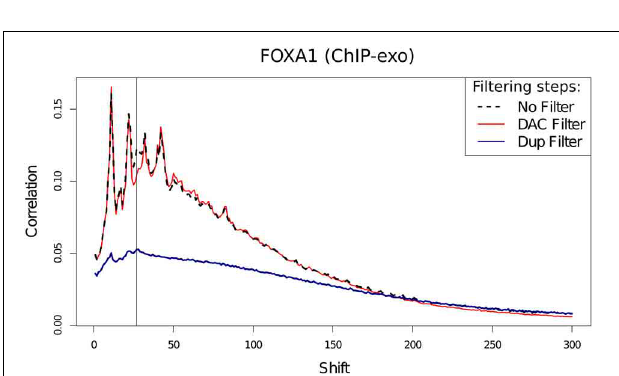
FIGURE 10 | Cross-correlation profile for FoxA1 ChIP-exo after no filtering, removal of DAC blacklisted regions and removal of duplicated